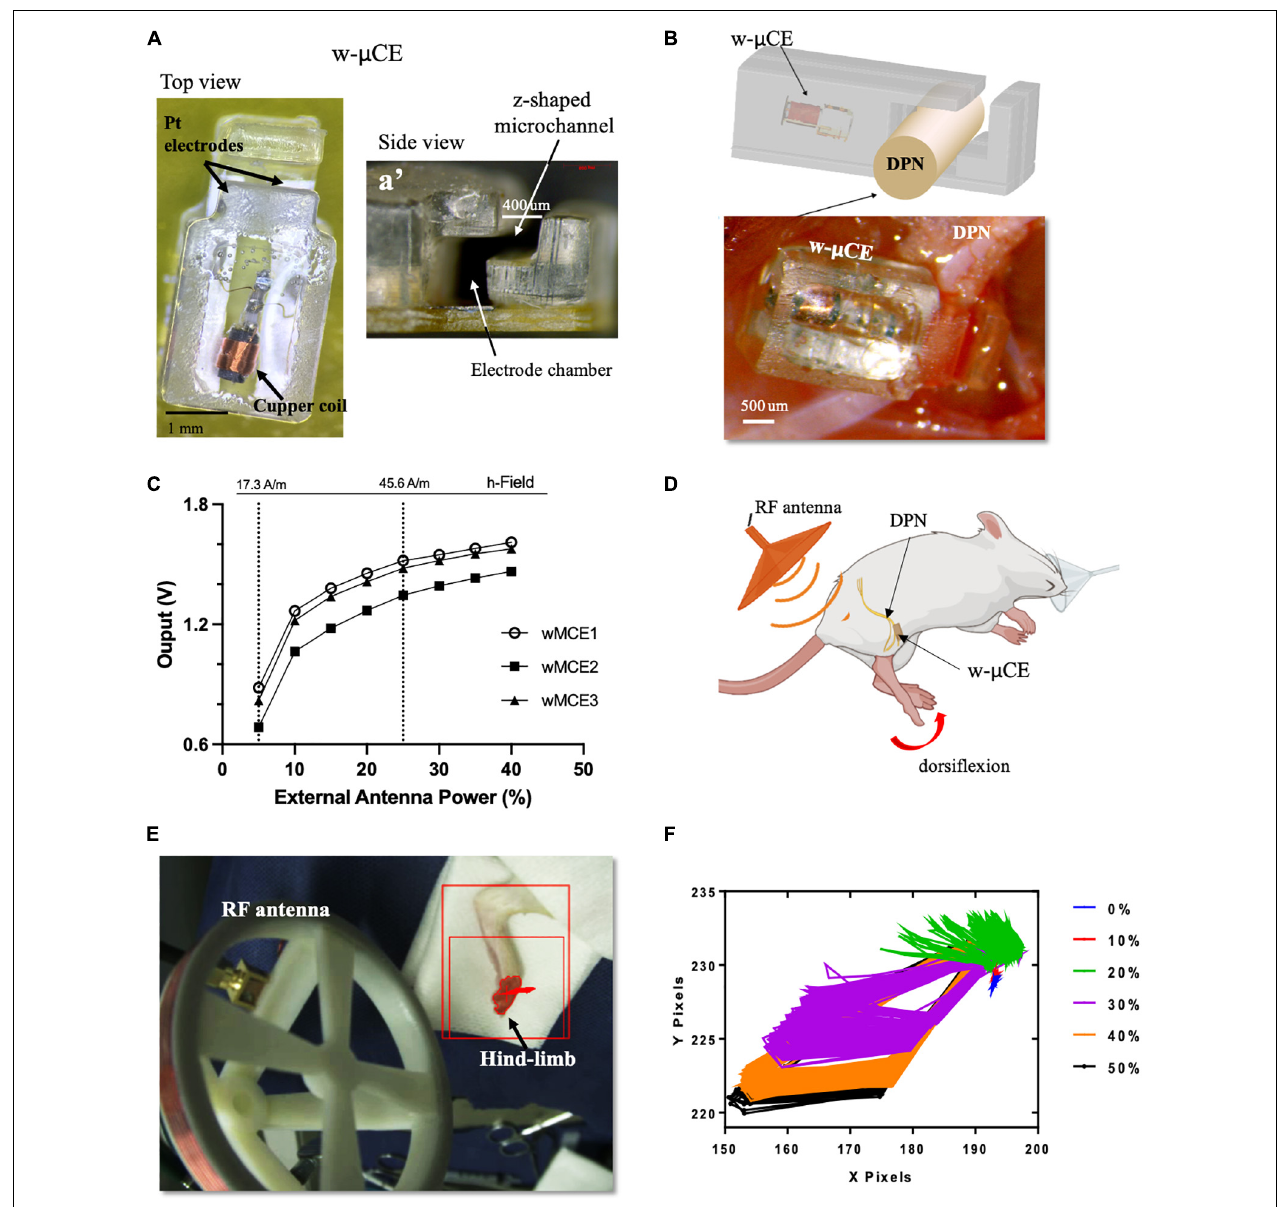
FIGURE 4 | w- µ CE for sub-chronic DPNS. (A) Picture of the w- µ CE top view. (A’) Side view of the insertion z-shaped channel and electrode chamber. (B) Schematic and picture of the w- µ CE implanted onto the DPN. (C) Voltage output from the w- µ CE as a function of power from the external antenna ( n = 3). (D) Illustration of the device implanted in the DPN and evoked dorsiflexion. (E) Placement of the external antenna, 3–4 cm from the w- µ CE; the hind-limb was stained to facilitate dynamic pixel tracking during videotaping. (F) Pixels tracked from the video recorded during DPNS sessions are displayed in an X/Y graph. The evoked movement was directly proportional to the RF power (0–50%). w- µ CE, wireless multichannel electrode; DPNS, deep peroneal nerve stimulation; RF, radio frequency.